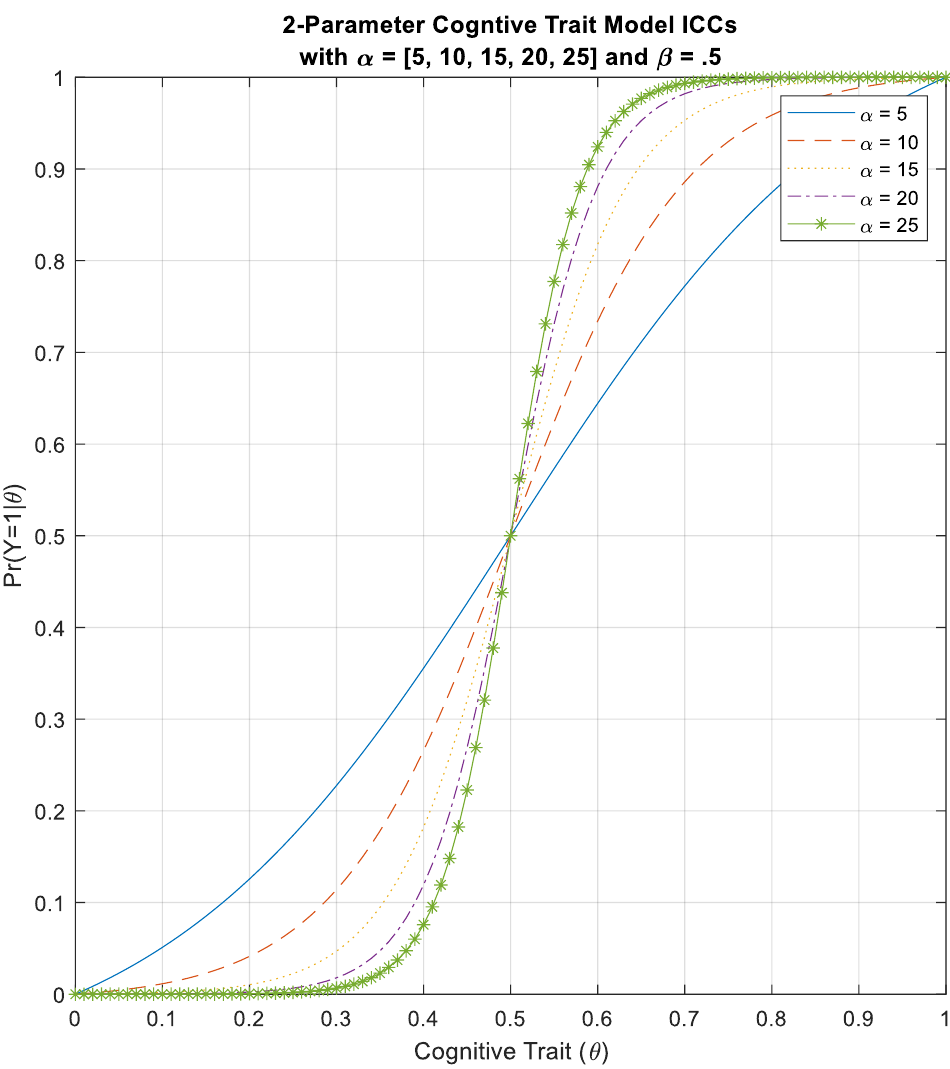
Figure 2. 2-Parameter Cognitive Trait Model Item Characteristic Curves over different α values (5, 10, 15, 20, 25) when β = 0.5.